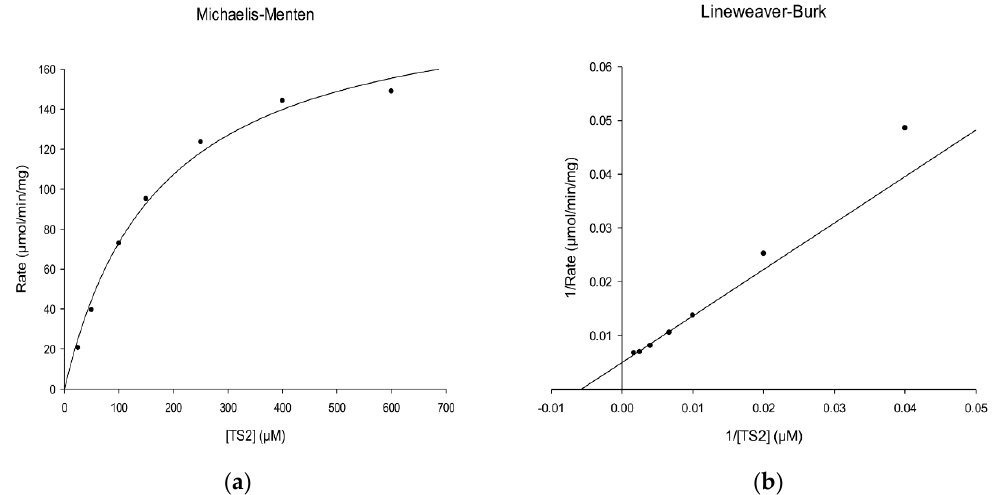
Figure 5. Kinetic characterization of rLmTR. ( a ) Michaelis–Menten and ( b ) Lineweaver–Burk double reciprocal plots.